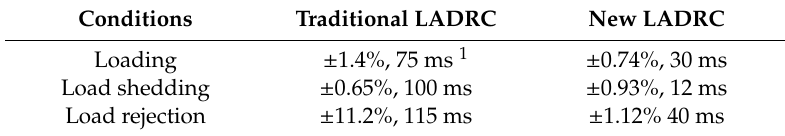
Figure 17. Dynamic response of a 1.5 MW permanent magnet synchronous generator (PMSG) with the traditional LADRC and new LADRC during the variation of machine side output: ( a ) Capacitor voltage at the machine side loading; ( b ) capacitor voltage at the machine side load shedding; ( c ) capacitor voltage at the machine side load rejection. Table 3. Control performance comparison under machine side output variation.